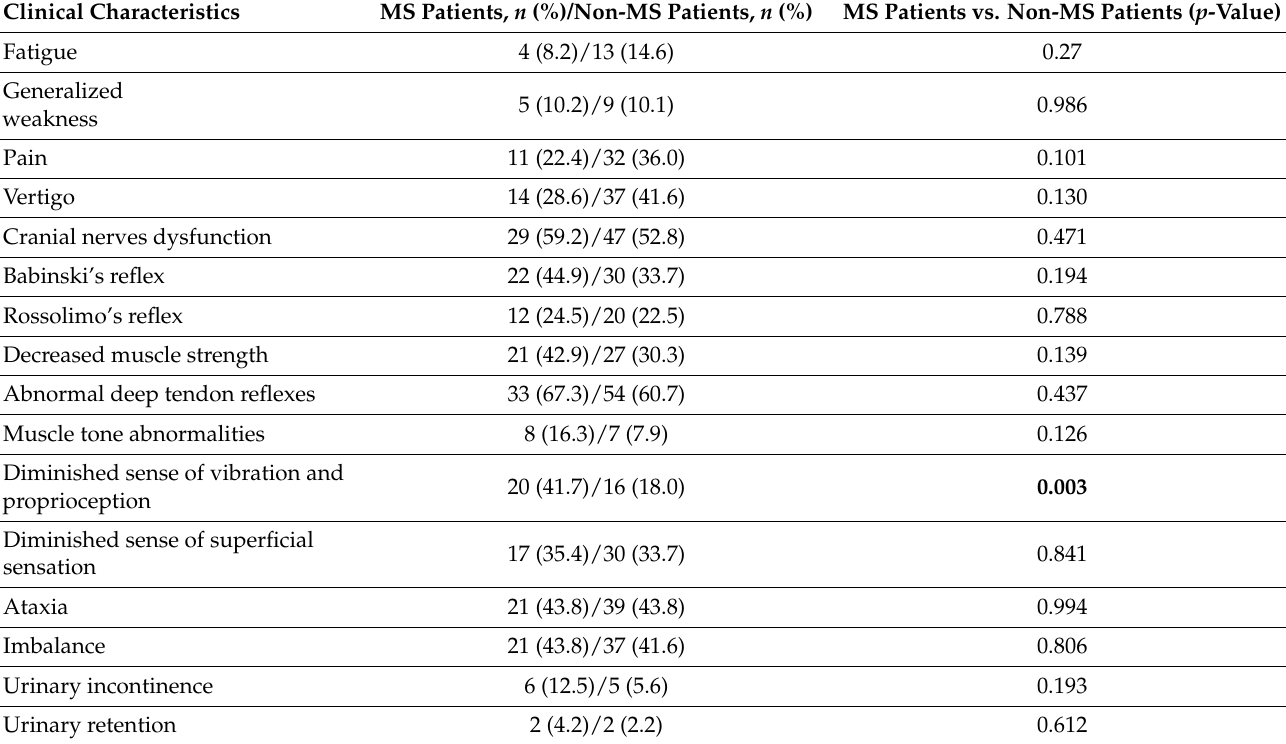
Table 2. Clinical characteristics of the study